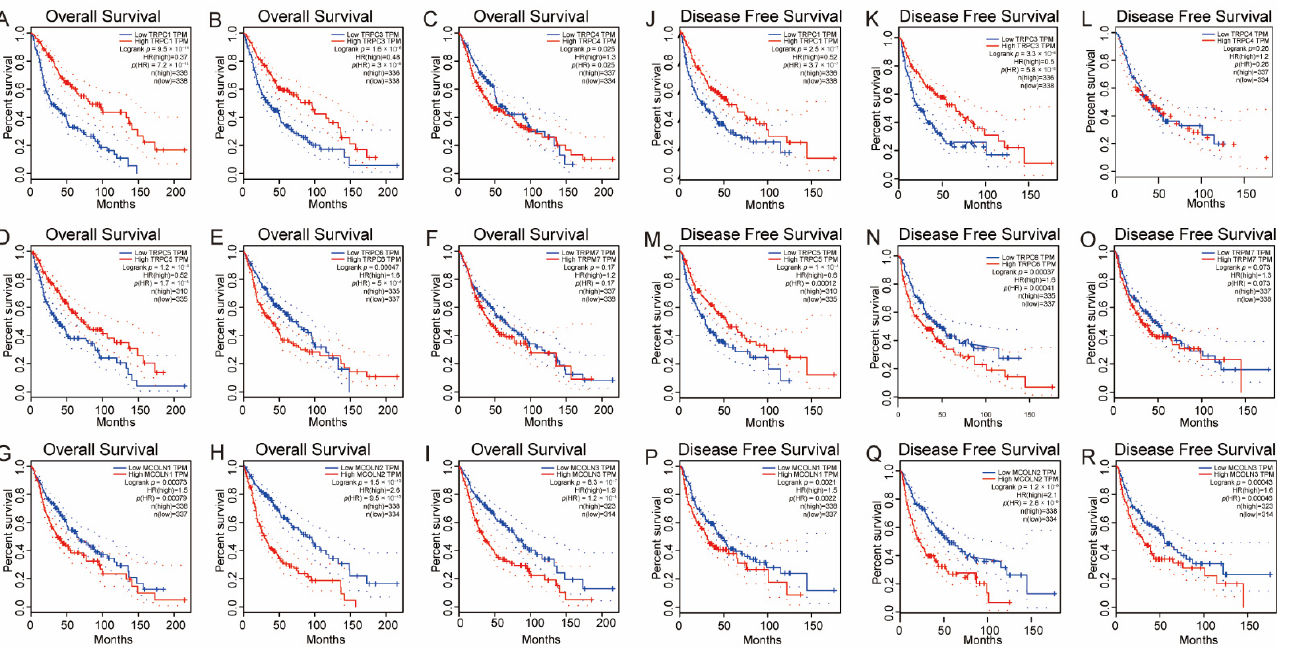
Figure 5. The dysregulation of hub genes of the TRPs family was correlated to OS and DFS time in glioma. ( A – I ) higher expression levels of TRPC1 ( A ), TRPC3 ( B ), and TRPC5 ( D ) were significantly associated with better OS time in glioma. Additionally, higher levels of TRPC4 ( C ), TRPC6 ( E ), MCOLN1 ( G ), MCOLN2 ( H ), and MCOLN3 ( I ) were significantly associated with worse OS time in glioma. ( J – R ) Similarly, higher levels of TRPC1 ( J ), TRPC3 ( K ), and TRPC5 ( M ) were significantly associated with better DFS time in glioma. Additionally, higher levels of TRPC6 ( N ), MCOLN1 ( P ), MCOLN2 ( Q ), and MCOLN3.